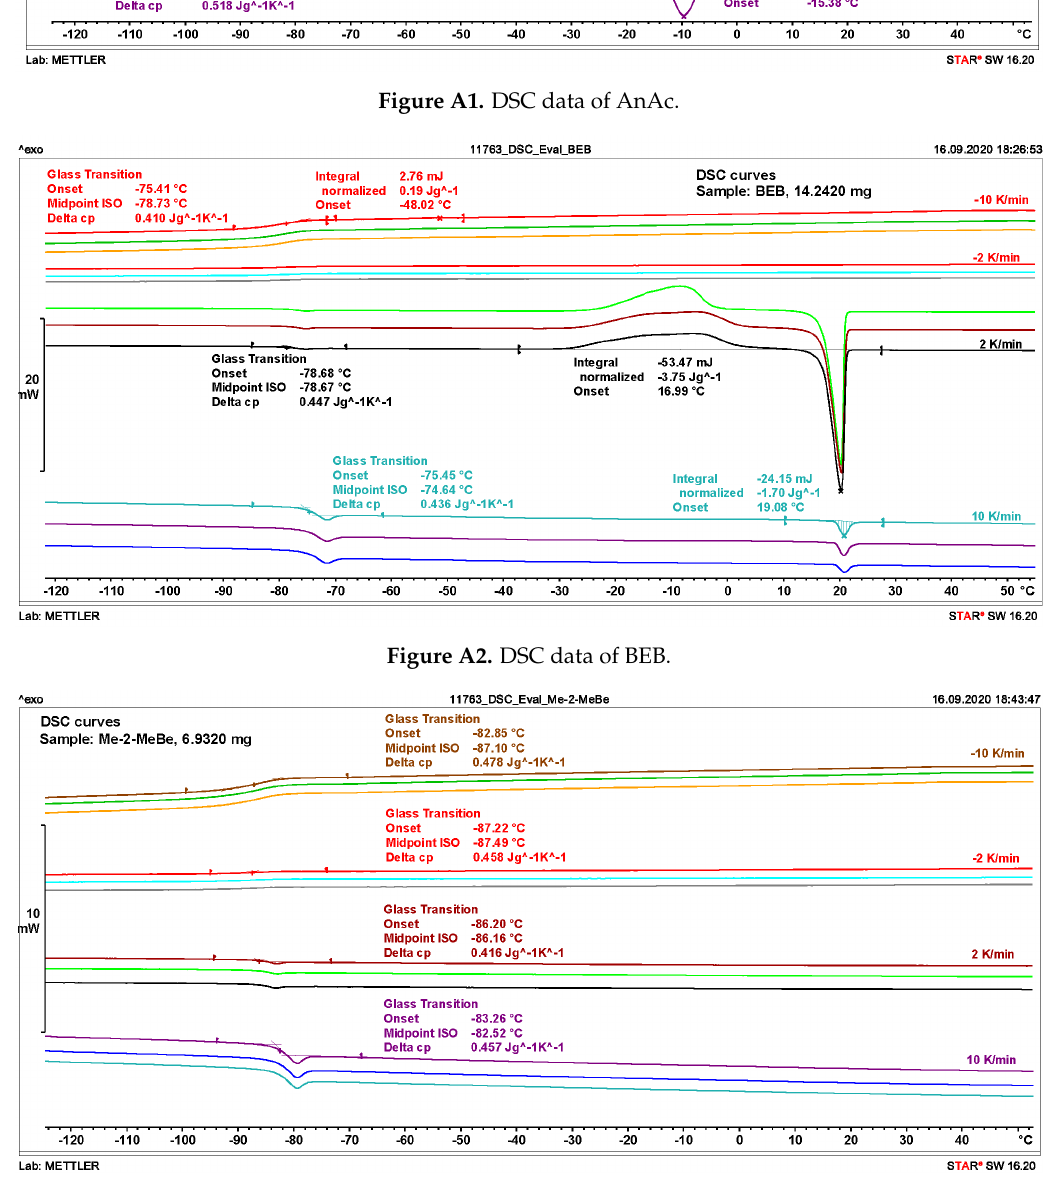
Figure A3. DSC data of